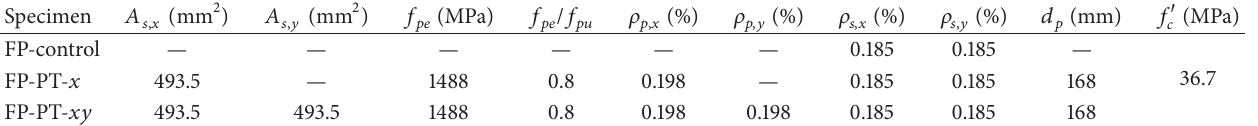
Table 2: Details of specimens.